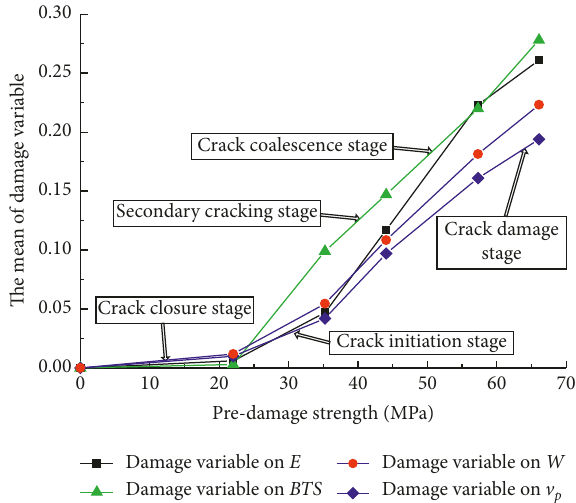
Figure 13: The mean of damage variables.